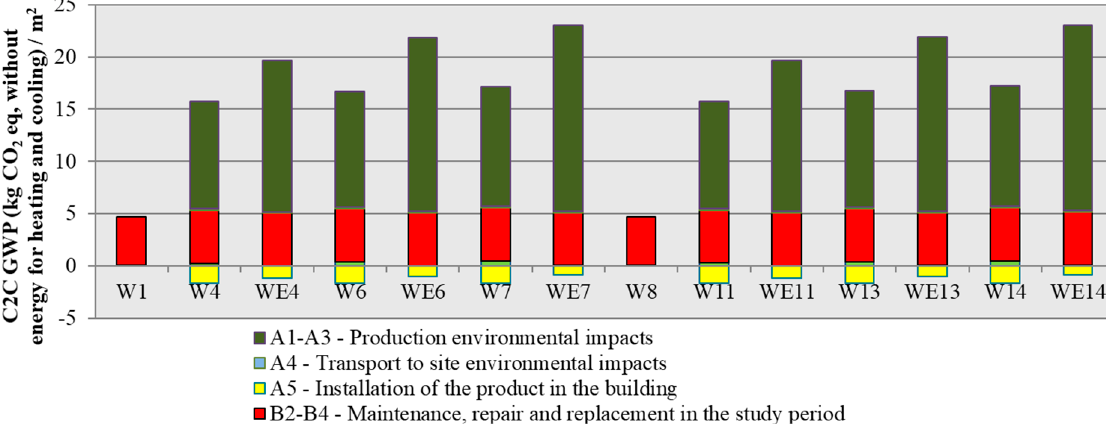
Figure 7. C2C Global Warming Potential (GWP, in kg CO 2 eq, without energy for heating and cooling)/m 2 of the external wall alternatives of ETICS with ICB and EPS.